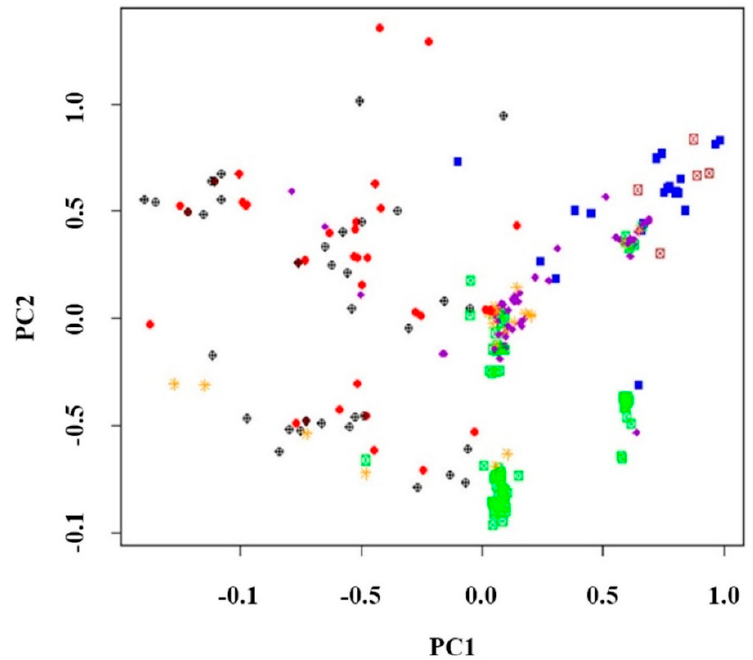
Figure 5. Principal component analysis (PCA) of 548 rice germplasms based on 16 SSR markers using R program. The colors shown in this figure represent the same genetic resources as the colors in Figure 5. The rice genotypes belonging to cluster 1 are indicated by red; cluster 2: blue; cluster 3: green; cluster 4: violet; cluster 5: orange; cluster 6: black; and cluster 7: